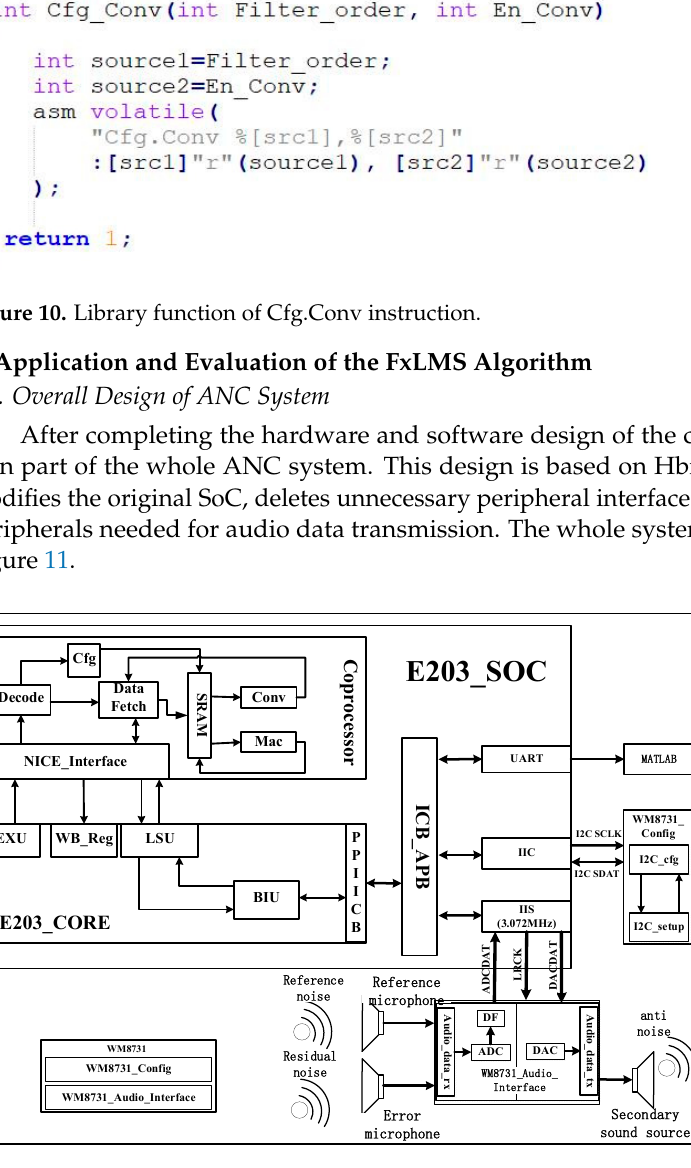
Figure 11. Circuit structure diagram of ANC system.